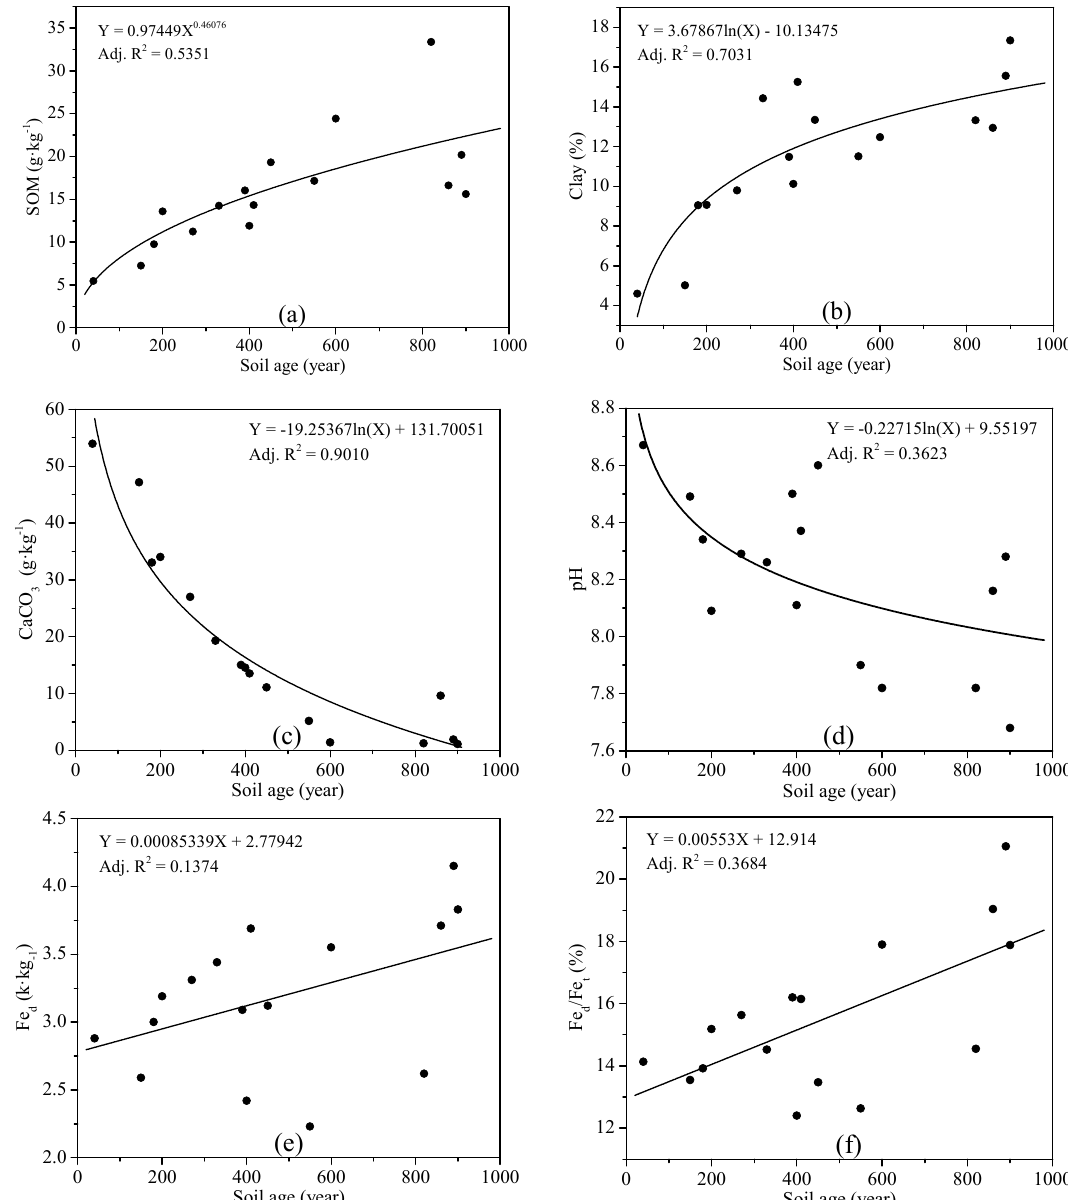
Figure 6. Changes in six soil properties with time in topsoil (0–5 cm) samples: ( a ) SOM; ( b ) clay; ( c ) CaCO 3 ; ( d ) pH; ( e ) Fe d ; ( f ) Fe d /Fe t .